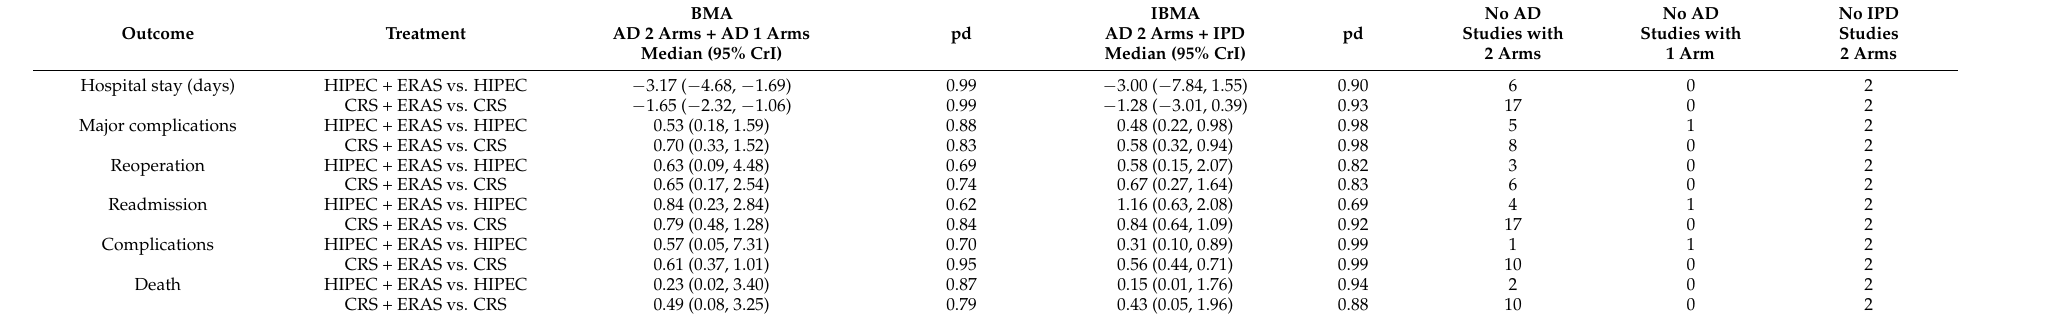
Table 4. Bayesian Meta-analyses on aggregated data (AD) and individual participant data (IPD) results. Outcome